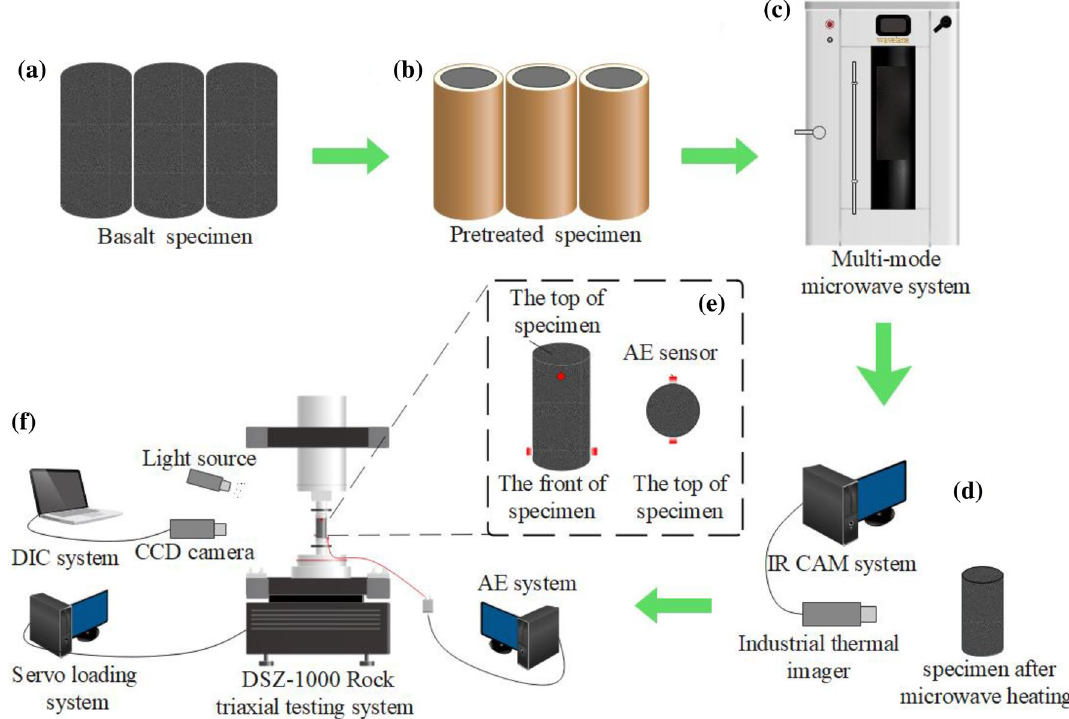
Figure 4. The main equipment and test flow chart. ( a ) Basalt specimen; ( b ) pretreated specimen; ( c ) multi- mode microwave system; ( d ) thermal imaging test; ( e ) arrangement of AE sensors; ( f ) uniaxial compressive testing